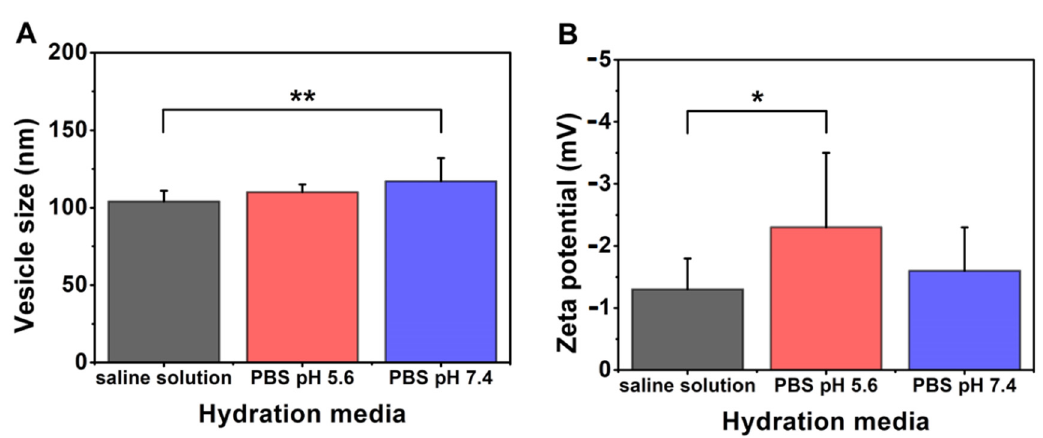
Figure 9. Characteristic features of the liposome samples prepared with different hydration media (saline solution, PBS pH 5.6 and 7.4) from PC-DPPE-PEG 2000 -CH 40:20:40 mass ratio composition at 60 °C, and lyophilised with glucose as cryoprotectant, presenting the results of the investigations: vesicle size and zeta potential analysis ( A , B ). *: p < 0.05; **: p < 0.01. Table 11. Measurement results of the liposome samples prepared with different hydration media (saline solution, PBS pH 5.6 and 7.4) from PC-DPPE-PEG2000-CH 40:20:40 mass ratio composition at 60 °C, and lyophilised with glucose as cryoprotectant.